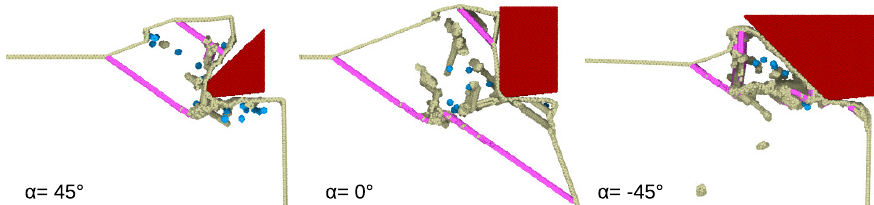
Figure A2. Same cutting systems as in Figure A1, but highlighting twinning boundaries (pink). Vacancies are shown in blue, while surfaces and dislocations are colored gray.